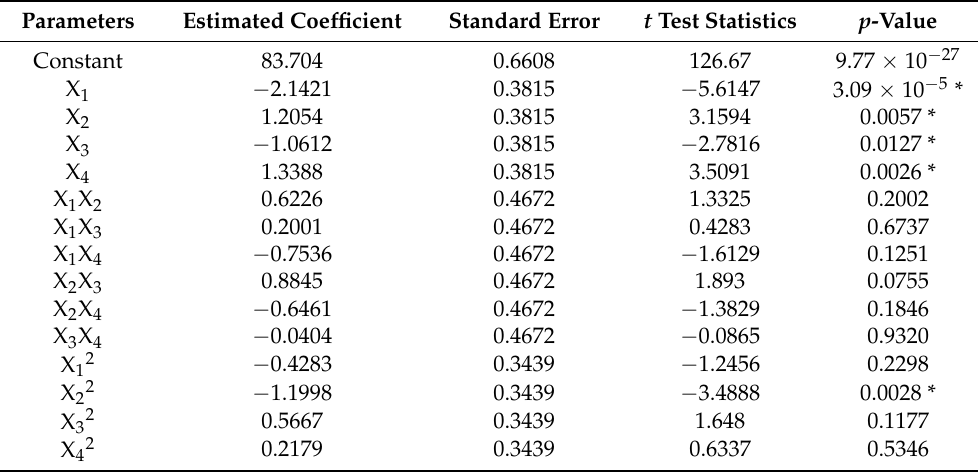
Table 3. Multiple regression analysis of the adsorption percentage of Congo red dye in the cocoa bean shell